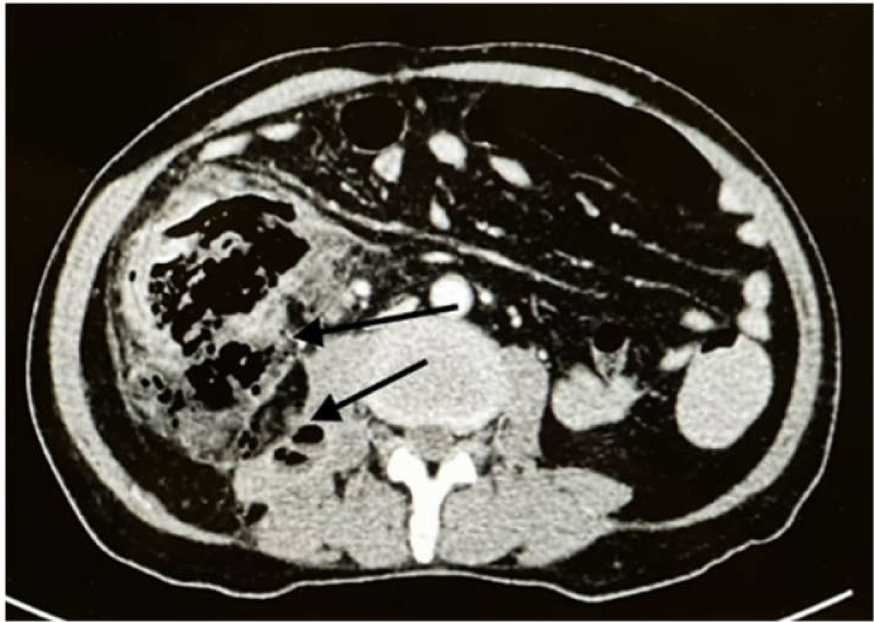
Figure 2. Axial CT with IV contrast showed cecal perforation with free air around the colon ( black arrows ).